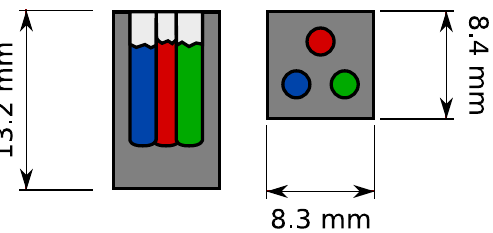
Figure 2. Schematic drawing of the phantom. The cuboid PMMA (dark grey) was drilled with three holes each of which was filled with a mixture of a selenium compound [elemental Se (red), Na 2 SeO 3 (green) and Na 2 SeO 4 (blue)] and starch. The holes were capped with tissue paper (light